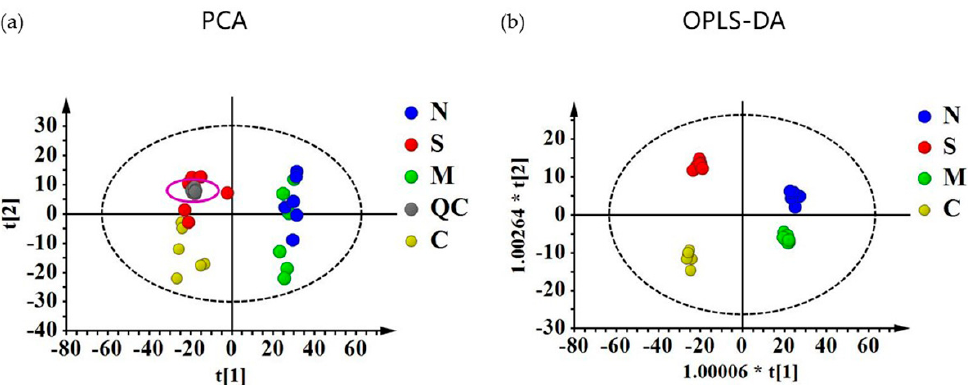
Figure 3. ( a ) Score plots of principal components analysis (PCA) and ( b ) orthogonal partial least squares discriminant analysis (OPLS-DA) models. C:NC samples, M:NC samples treated with SSd, S: siNRP-1 samples, N: siNRP-1 samples treated with SSd.